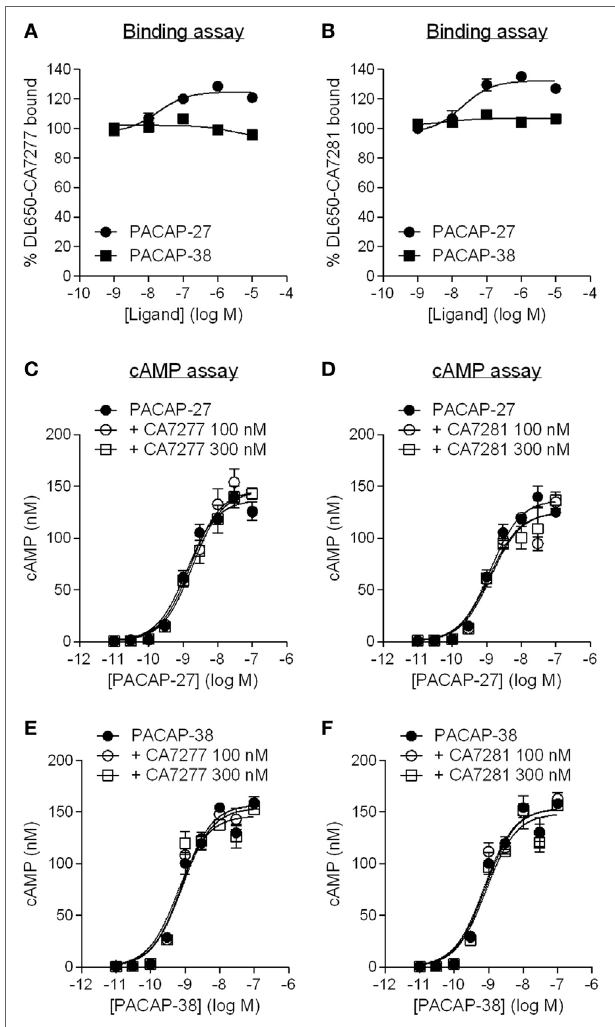
FigUre 6 | Effect of nanobodies on pituitary adenylate cyclase-activating polypeptide (PACAP)-bound VPAC1. Binding of DyLight 650-conjugated CA7277 (a) and C7281 (B) on CHO cells expressing VPAC1 in presence of increasing concentrations of PACAP-27 (filled circles) or PACAP-38 (filled squares). Effect of CA7277 (c,e) or CA7281 (D,F) at 100 or 300 nM on cAMP accumulation promoted by increasing concentrations of PACAP-27 (c,D) or PACAP-38 (e,F) in CHO cells expressing VPAC1. The results are the means ± SEM of three independent experiments performed in